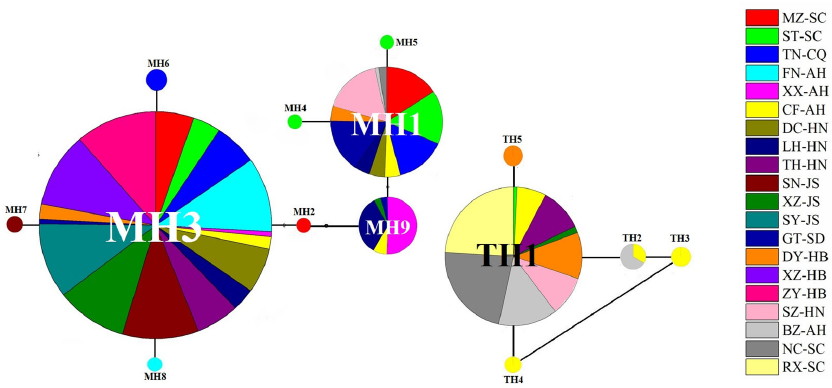
Figure 4. The TCS network for haplotypes of P. major and P. tectus populations based on the sequence of the COI gene. The haplotype network diagram was constructed in TCS 1.21, and then the color was added in PowerPoint.